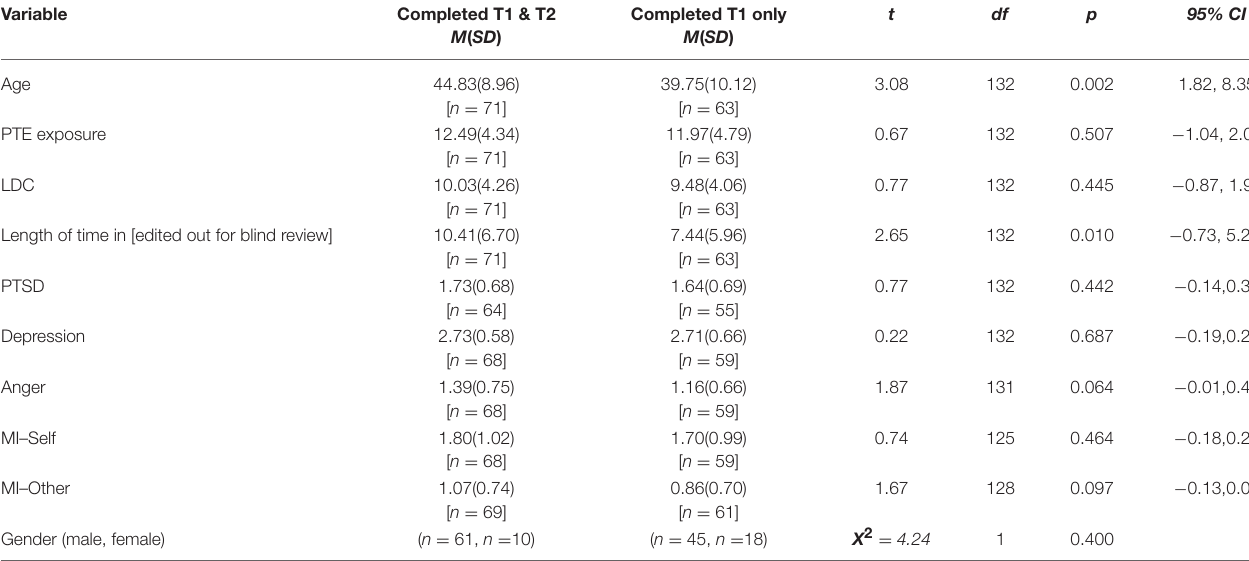
TABLE 1 | Differences between participants who completed time 1 and time 2 survey measures, and participants who completed only time 1 survey measures ( t -tests).